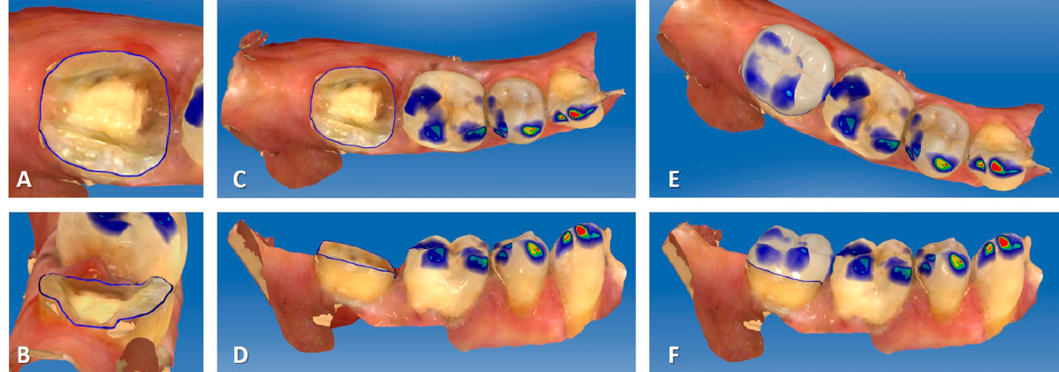
Figure 2. Cerec ® screenshots for endocrown modeling (( A ): occlusal view of the preparation; ( B ): distal